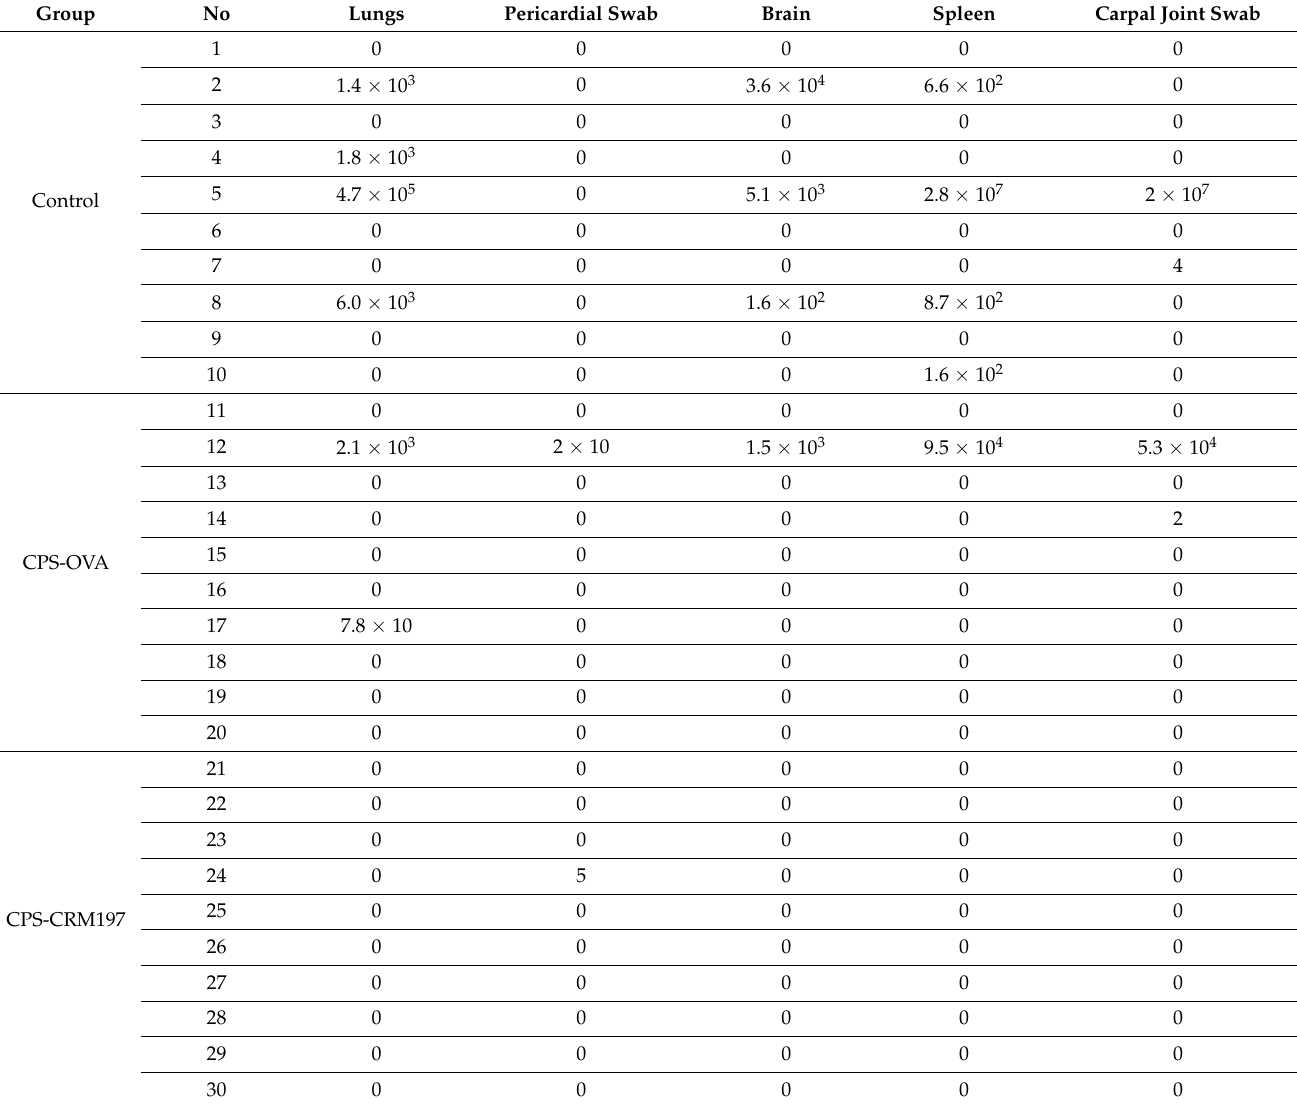
Table 1. S. suis serotype 2 colony number per gram of